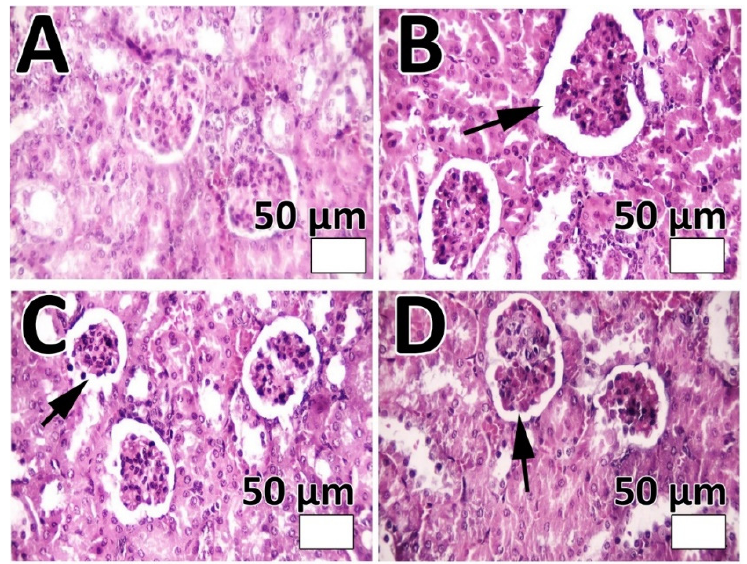
Figure 6. Results of renal histopathological studies in ( A ) control; ( B ) DOX + CB; ( C ) Lip-DOX/CB; and ( D ) PEG-Lip-DOX/CB receiver groups of glioblastoma-bearing rats. As the results show, acute tubular necrosis was more evident in DOX + CB group, compared to Lip-DOX/CB and PEG-Lip- DOX/CB groups. Arrows show acute tubular necrosis (Magnification ×40).